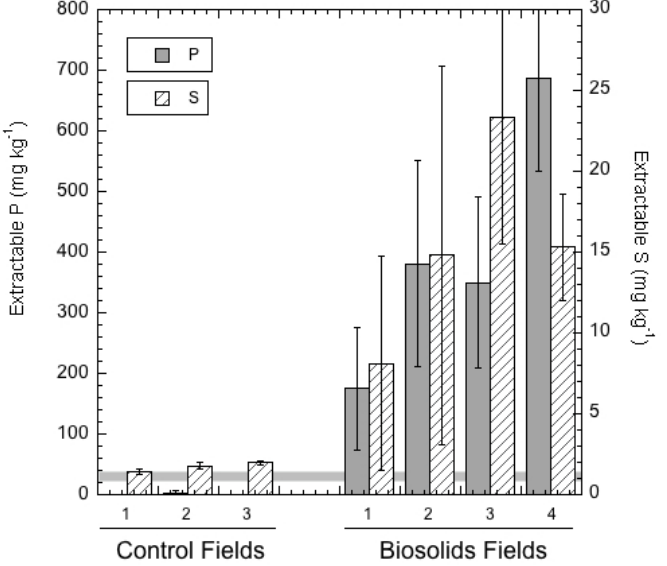
Figure 2. Extractable (by Modified Morgan solution) P and S in soils from the control (n = 3) and biosolids–amended (n = 4) fields. The horizontal grey band marks the 20–40 mg kg − 1 level of ex- tractable P considered to be the threshold for excessive available P in agricultural soils.